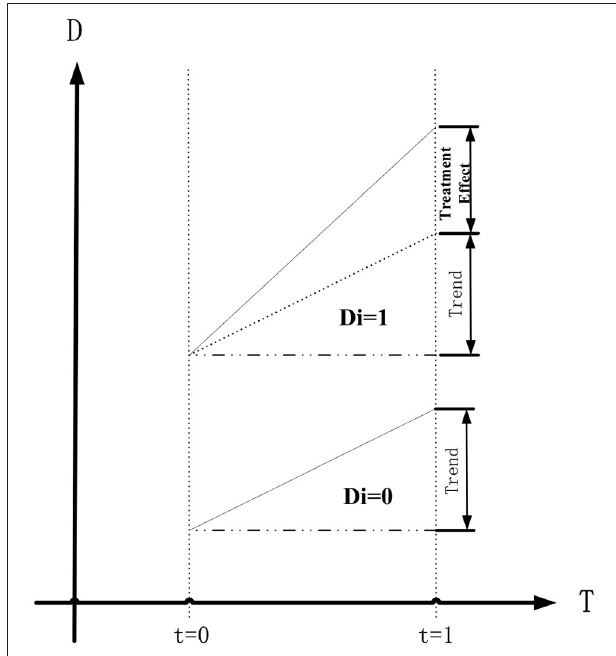
TABLE 1 | Screening results of ID resignation announcements from 2014 to